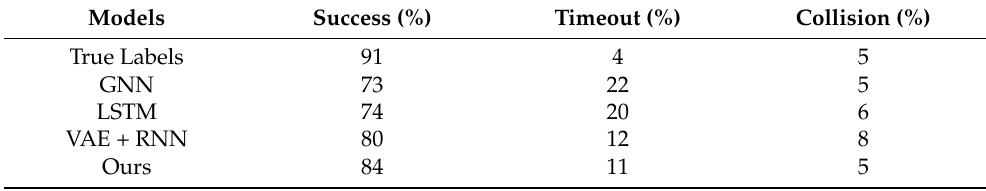
Table 2. Objective evaluation decision results of self-driving strategies with aggressive drivers p = 0.4.